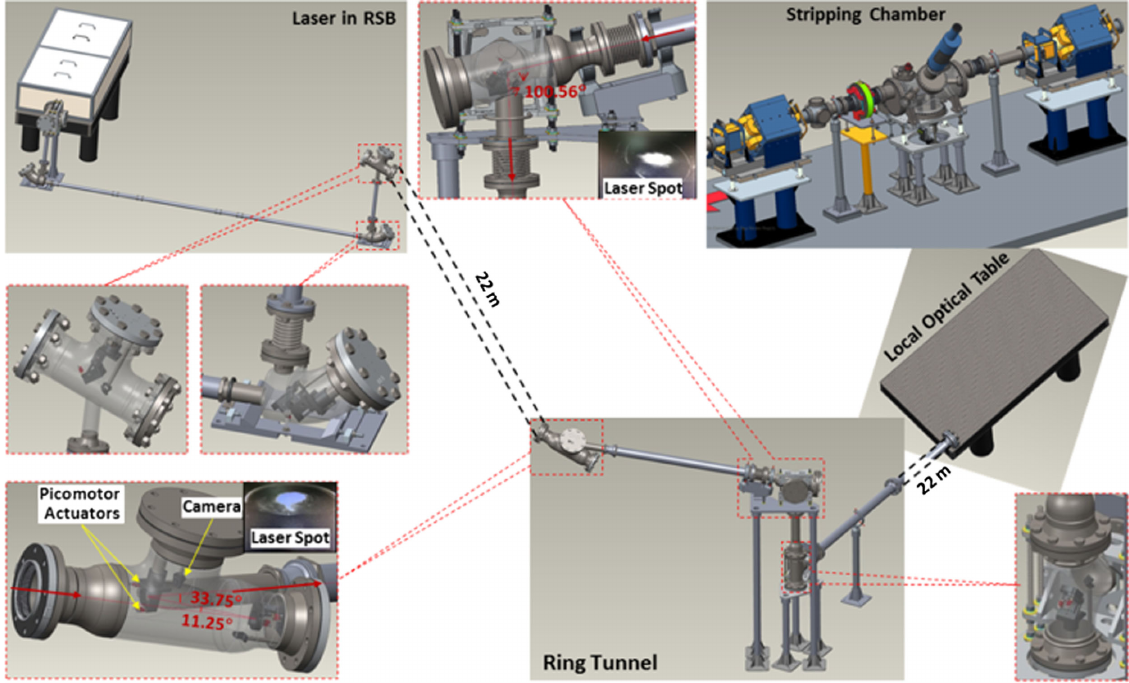
FIG. 21. Schematic of laser transport line. The remote station is located in the SNS ring service building, and the laser beam is transported through a 20 m chase to the ring injection area in the accelerator tunnel using mirrors M1 – M8. The optics boxes contain turning mirrors, picomotors, and laser beam position monitoring